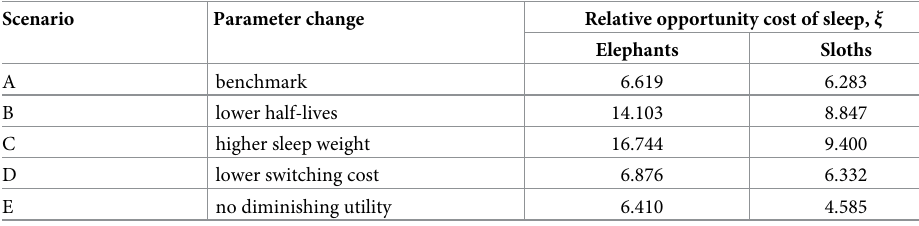
Table 3. Sensitivity